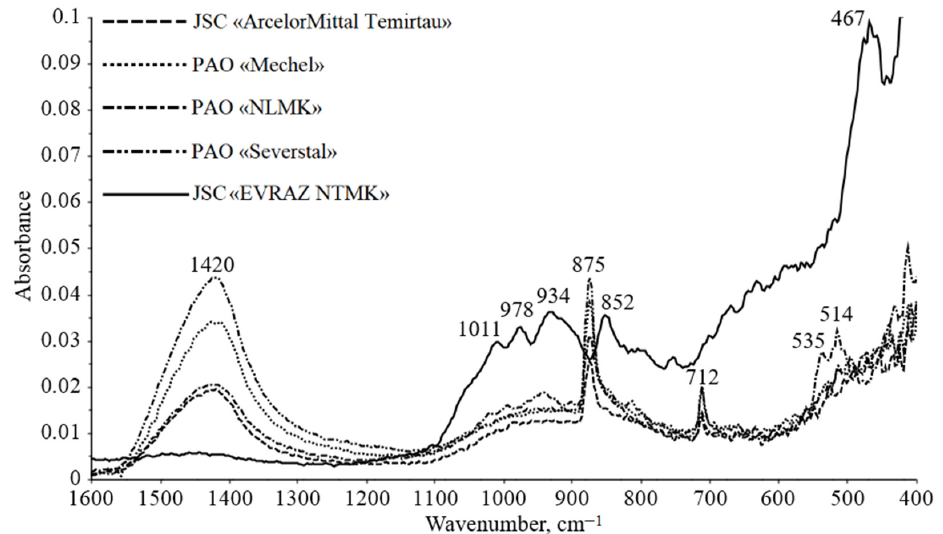
Figure 3. FTIR spectra profile of granulated blast furnace slag samples from calibration (PAO Severstal, PAO NLMK, PAO Mechel and JSC ArcelorMittal Temirtau) and test (JSC EVRAZ NTMK) sets in the range 1600–1200 cm − 1 .